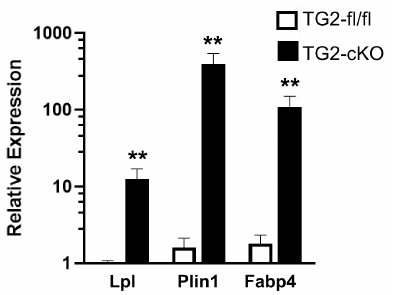
Figure 8. Deletion of TG2 from astrocytes increases the expression of genes that facilitate neuron- astrocyte metabolic coupling following SCI. TG2-A-cKO and TG2fl/fl mice at 12–16 weeks of age (4 mice in each group) were collected at 3 days post-injury, spinal cords removed and a 5 mm section of the spinal cord surrounding the lesion was used to prepare RNA followed by reverse transcription and for qPCR. Fatty acid binding protein 4 (Fabp4) is a carrier protein of fatty acids and likely facilitates the transport of fatty acids from neurons to astrocytes. Lipoprotein lipase (Lpl) degrades lipoprotein particles and thus upregulation would allow more fatty acids to enter the astrocytes and perilipin 1 (Plin1) increases the storage capacity of lipid droplets in astrocytes. Gapdh was used as a control. N = 3 for each group. ** p < 0.01, unpaired t -test.